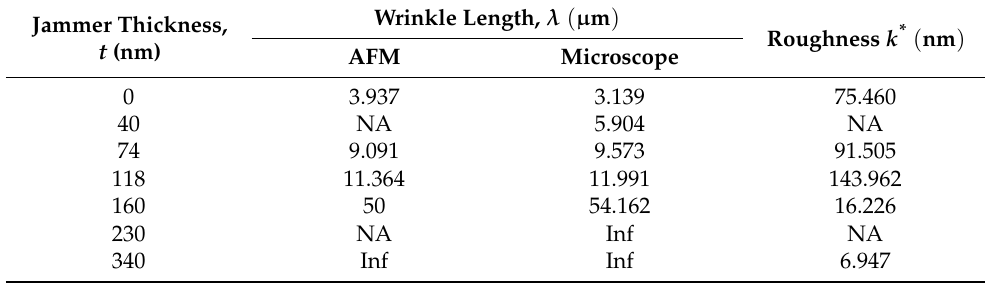
Table 1. Characteristics of wrinkles in a 40 nm thick Al film over a 1 mm-PDMS substrate coated with various t . Roughness, k ∗ , is the first order moment of surface roughness measured by an AFM with a scanning area of 50 µ m × 50 µ